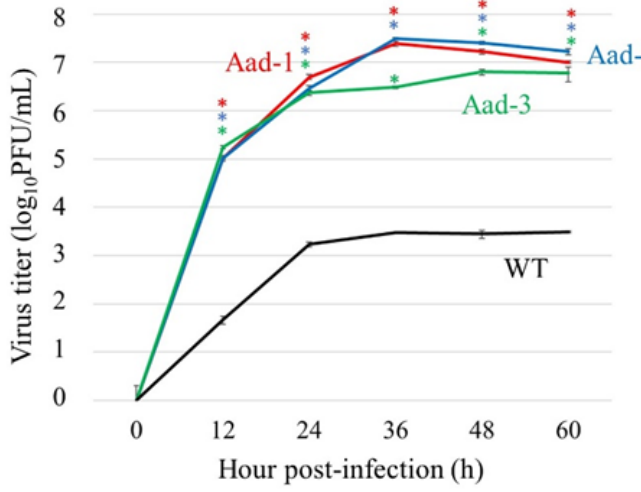
Figure 1. Growth kinetics of A549-adapted viruses in A549 cells. The cells were infected with A549- adapted (Aad-1, Aad-2, and Aad-3) or wild-type (WT) viruses at a multiplicity of infection of 0.01 at 37 °C. Supernatants were harvested at the indicated time points. Virus titers were determined using a plaque assay in MDCK cells. Data present the means ± standard deviation (SD) of the results of three independent experiments. * p < 0.05, compared with that of the WT virus using Dunnett’s test.